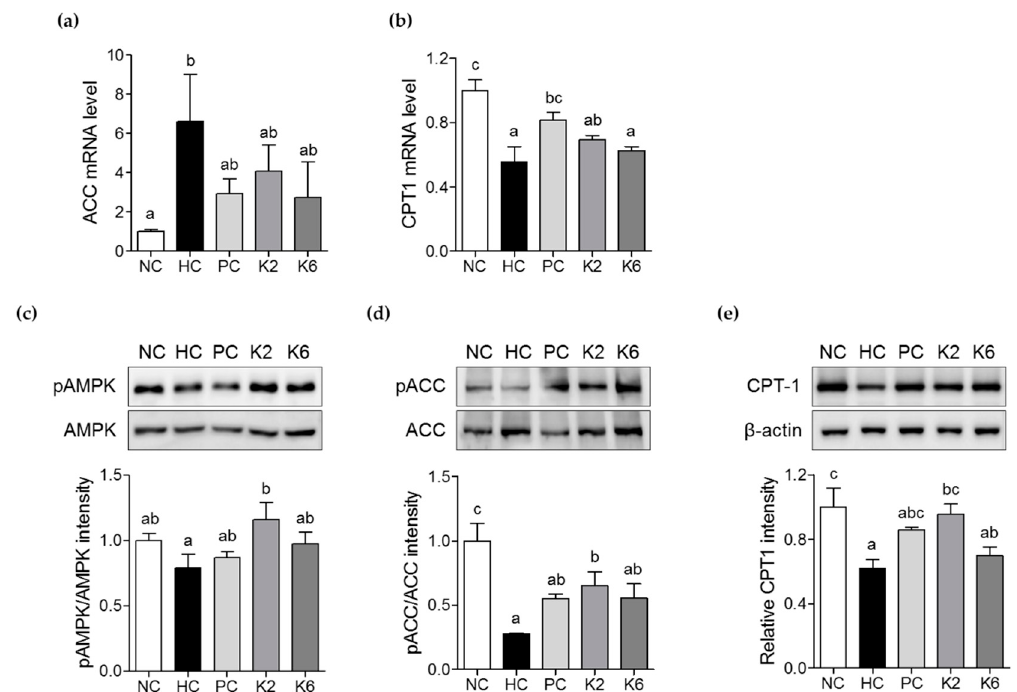
Figure 7. Effects of K2 and K6 on mRNA, protein, and phosphorylation levels of lipid metabolism-related markers in the rat model of HF/HF-induced NAFLD. mRNA expression levels of ( a ) ACC and ( b ) CPT-1 in the liver. Western blot analysis of ( c ) phosphorylated and total AMPK, ( d ) phosphorylated and total ACC, and ( e ) CPT-1 in the liver. Total AMPK and ACC were used as protein loading controls for phosphorylated AMPK and ACC, respectively. NC, normal diet control; HC, HF/HF diet control; PC, HF/HF diet with silymarin; K2, HF/HF diet with ATG-K2; K6, HF/HF diet with ATG-K6; AMPK, AMP-activated protein kinase; ACC, acetyl-CoA carboxylase; CPT-1, carnitine palmitoyltransferase-1. The data are presented as mean ± SD. Means with different letters (a, b, and c) are significantly different, p < 0.05, whereas those with similar letters are not different. The groups were compared using one-way ANOVA followed by Duncan’s multiple range tests.